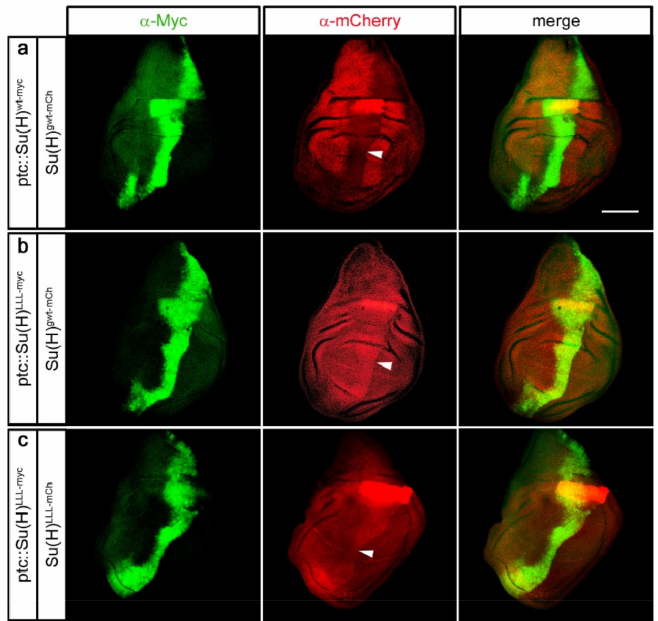
Figure 4. Competition between endogenously and ectopically expressed Su(H). ( a – c ) Expressions of UAS-Su(H) wt-myc and Su(H) LLL-myc constructs were locally induced along the antero–posterior boundary with ptc-Gal4 as indicated, and detected specifically with anti-myc antibody staining (green). Endogenous Su(H) protein expression was visualised by mCherry antibody staining (red) [44]. ( a ) Overexpression of wild type Su(H) wt-myc results in the disappearance of the en- dogenous Su(H) gwt-mCh protein (arrowhead). ( b ) In contrast, overexpression of H-binding deficient Su(H) LLL-myc causes enrichment of endogenous Su(H) gwt-mCh protein (arrowhead). ( c ) A similar, albeit weaker enrichment is observed for Su(H) LLL-mCh upon overexpression of Su(H) LLL-myc . Arrow- heads mark the position of the antero–posterior boundary in ( a – c ). Size bar, 100 µ m. Genotypes are: ptc-Gal4 Su(H) gwt-mCh /Su(H) gwt-mCh ; hs-Su(H) wt-myc /+ ( a ), ptc-Gal4 Su(H) gwt-mCh /Su(H) gwt-mCh ; hs-Su(H) LLL-myc /+ ( b ), ptc-Gal4 Su(H) LLL-mCh /Su(H) LLL-mCh ; hs-Su(H) LLL-myc /+ ( c